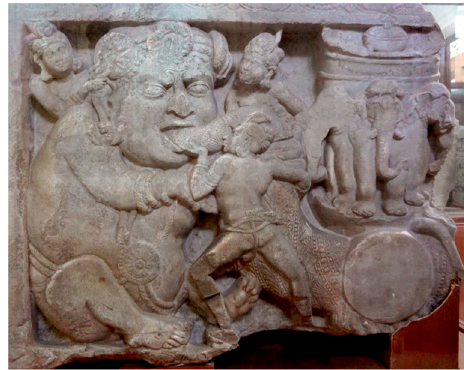
Figure 14. Rear side of relief no. 75 in Chennai Government Museum © photograph Wojtek Oczkowski.